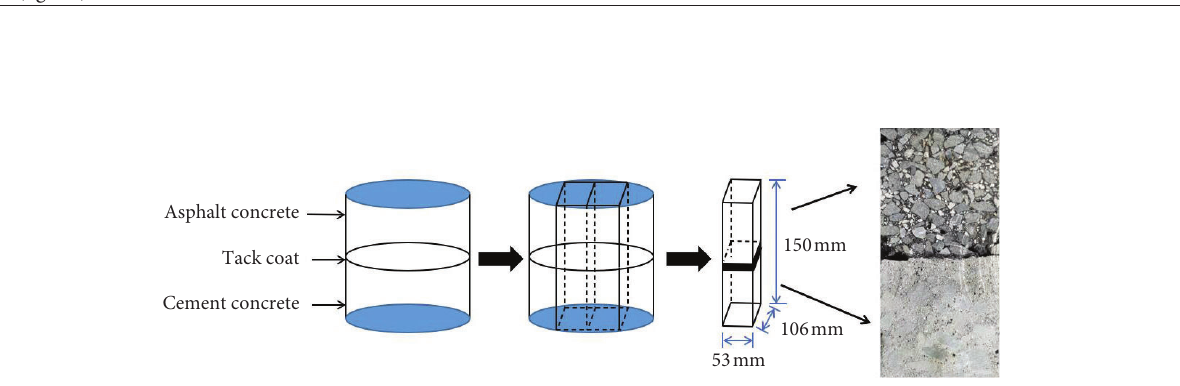
Figure 3: Sample